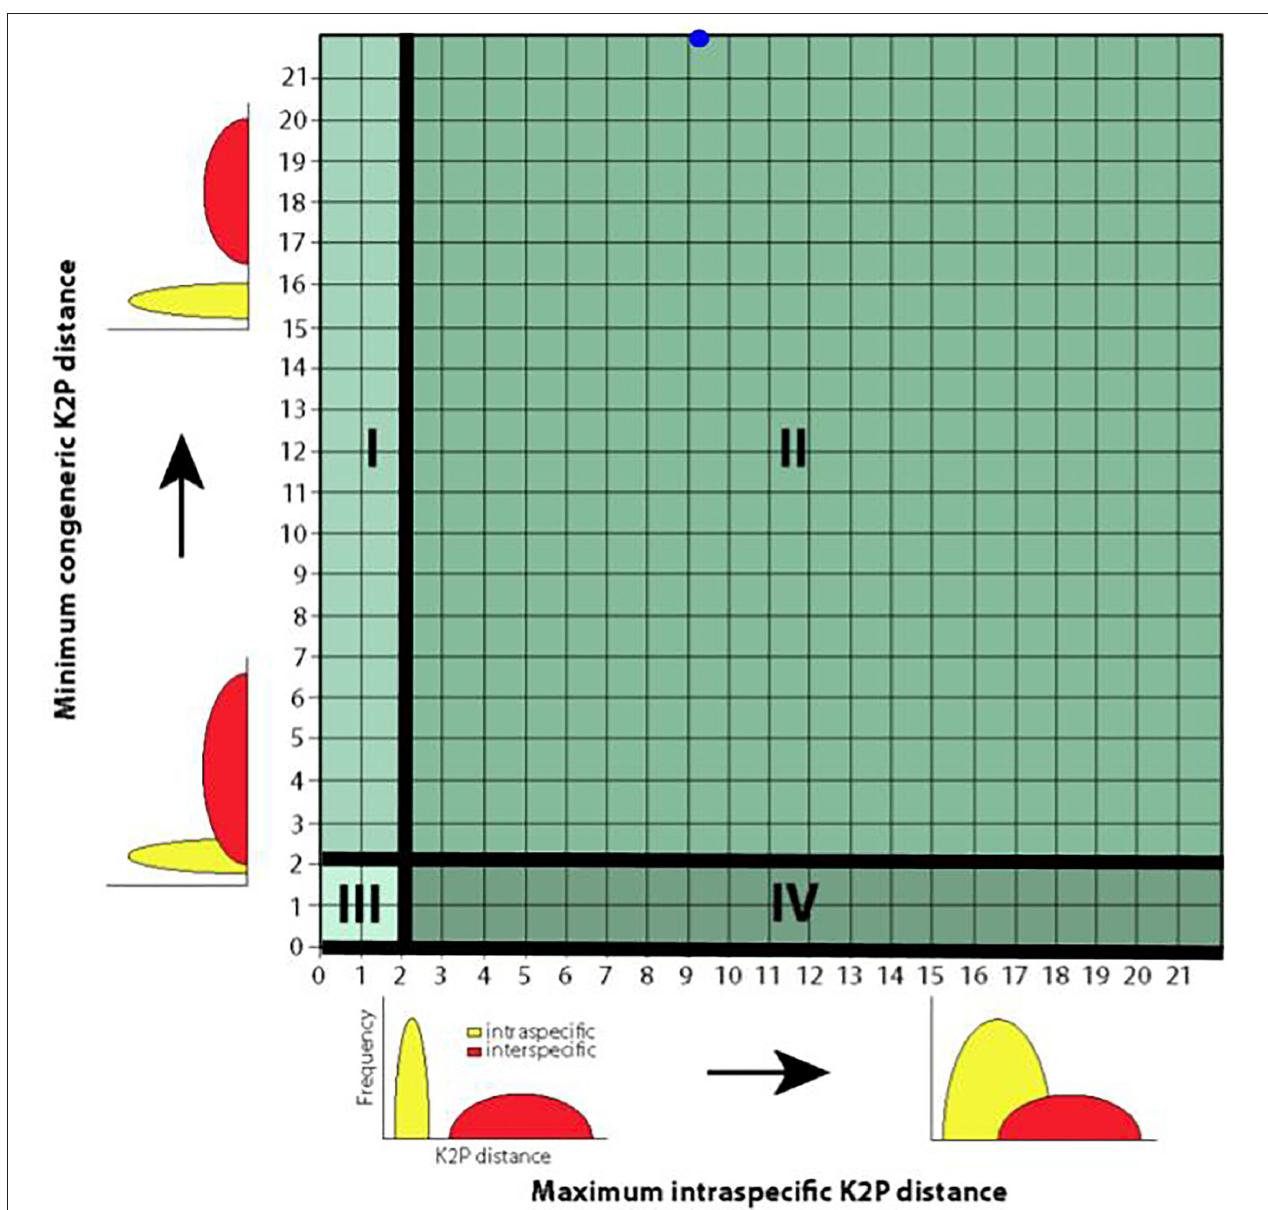
FIGURE 3 | Quadrant plot for the depiction of species’ genetic distances reproduced with modification from Hubert and Hanner (2015). Such plots are informative since problematic and/or “outlier” species can be easily detected and the success/performance of DNA barcoding assessed. Species are partitioned into four mutually exclusive groups (labeled I–IV) based on observed magnitudes of intra-specific and interspecific genetic distances. Here, a 2% distance threshold is assumed to separate most taxa. Solid black lines aid visual resolution of the quadrants. The blue dot at the approximate point (9.22, 22.78) within Quadrant II represents Cyclothone atraria , a likely cryptic species complex. Plot axes show the relationship to the density curves shown in Meyer and Paulay (2005). Theoretically, between-species genetic variation should greatly exceed barcode sequence variation observed within species (Quadrant I; minimum interspecific distance maximum intra-specific distance > 2%). Practically, this will only be the case when specimens have been adequately